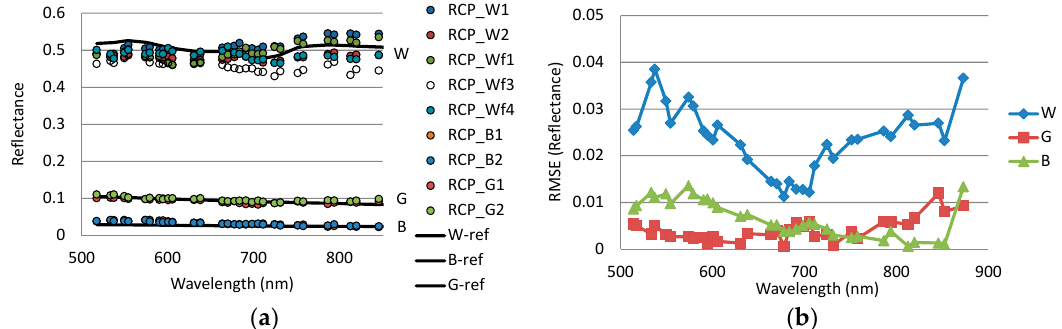
Figure 16. Evaluation of quality of the mosaics using reflectance panels. ( a ) Spectra of white (W), grey (G) and black (B) reflectance panels; ( b ) RMSEs of residuals of panel spectra in corrected data with respect to the reference spectra for each panel. RCP: Radiometric control point; W-ref, B-ref and G-ref show the reference spectra measured in laboratory.